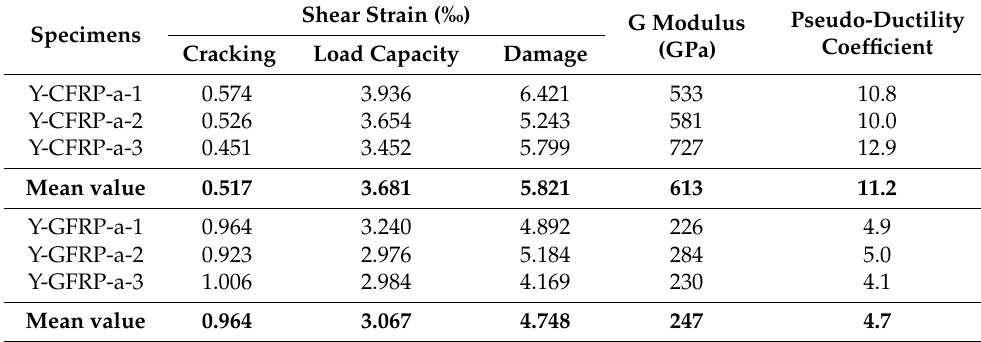
Table 6. Deformation parameters characterized the walls strengthened in configuration